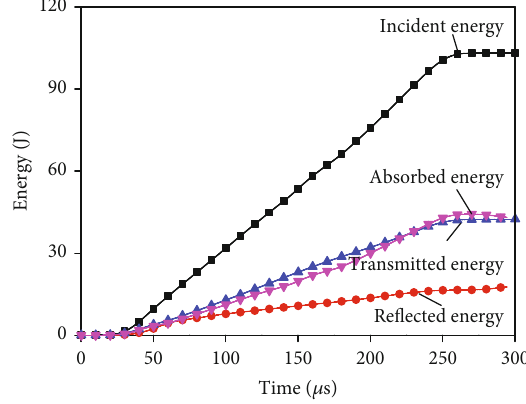
Figure 11: The time-history curve of energy under impact